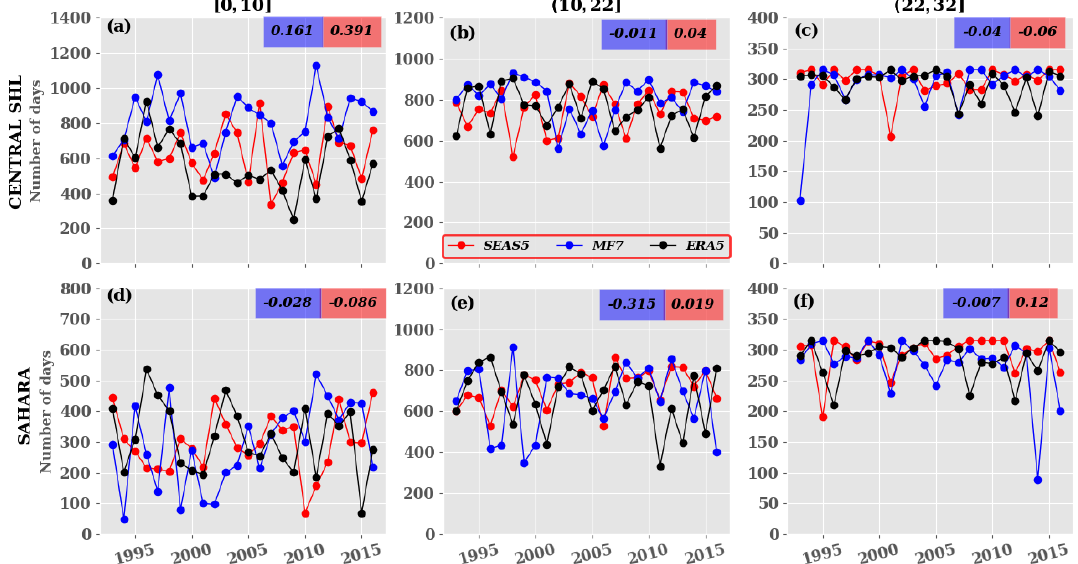
Figure 4. Interannual variability of significant days: significant days here refer to days with a spectral power signal greater than 1. Red, blue and black curves represent the number of days for SEAS5, MF7, ERA5 respectively over the (a–c) central SHL and (d–f) Sahara. The values in red and blue boxes refer to the correlation between SEAS5 and ERA5 and between MF7 and ERA5 respectively. The terms [ 0 , 10 ] , ( 10 , 22 ] and ( 22 , 32 ] are the different classes of days identified for the present study. The computation was made just using the unperturbed member of the ensemble forecast models launched from 1 June for the JJAS period. The y axis represents significant days and x axis the